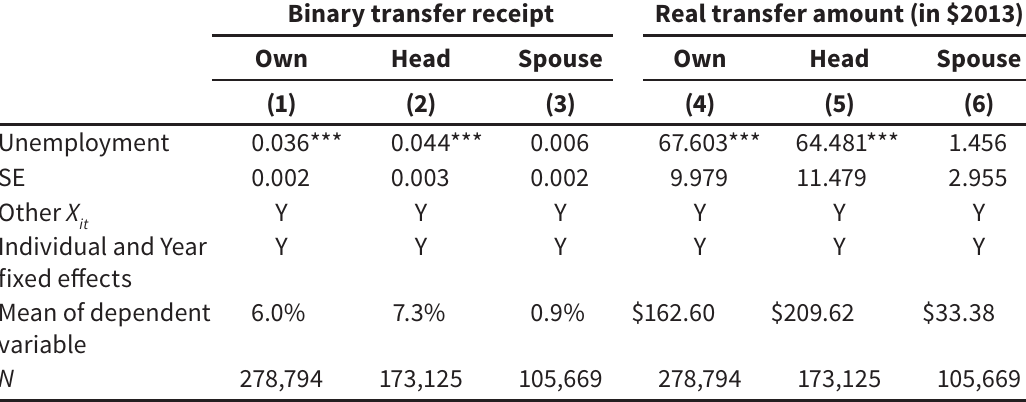
Coefficient estimate of regression of family transfer receipt on unemployment, by variable construction, heads of household and spouses aged 19–59 years, 1976–2013 PSID Binary transfer